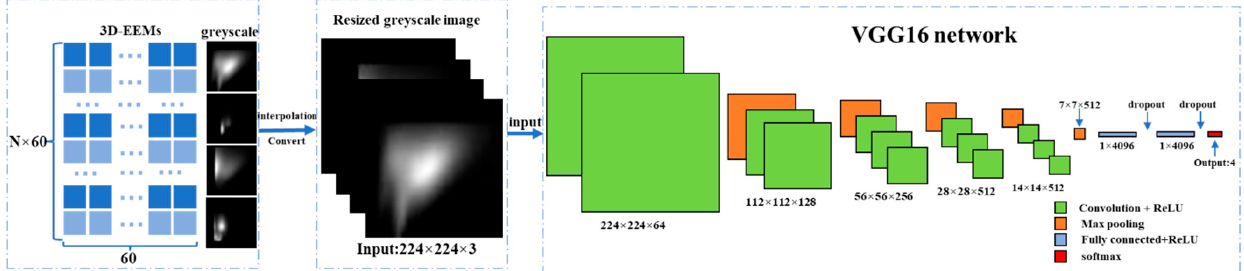
Figure 4. 3D-EEMs classification network based on VGG16. The size of the image is interpolated from size (60 × 60) to size (224 × 224) using the bilinear interpolation method. Grayscale images are converted into 3-channel RGB images using the Python Pillow function: Image.convert (“RGB”), which uses the Floyd–Steinberg dither method [29].